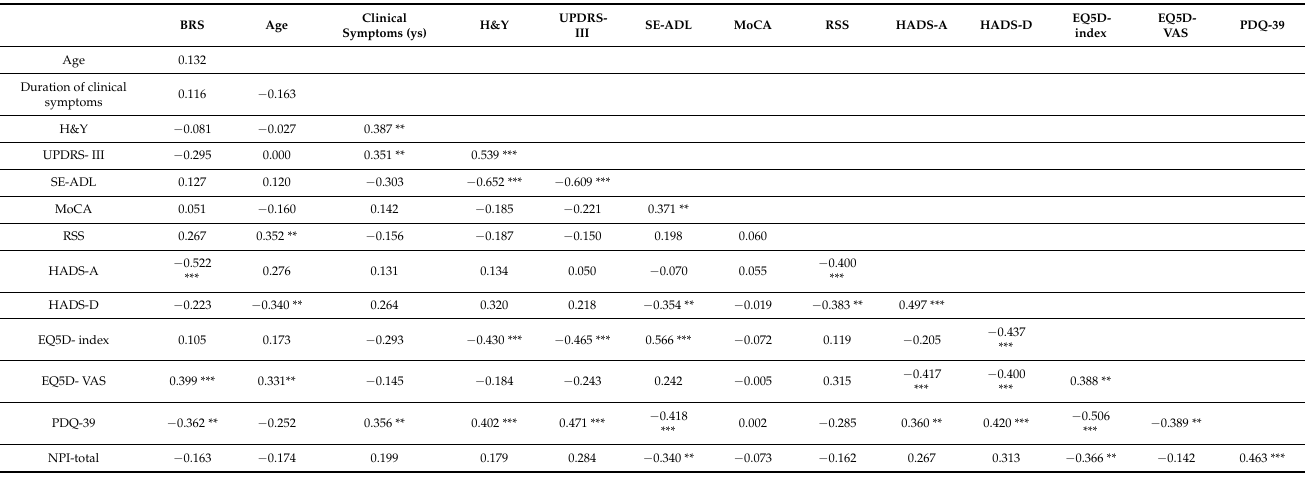
Table 4. Spearman correlation analyses among characteristics of people with Lewy body-related cognitive disorder and clinical outcomes ( n = 76).